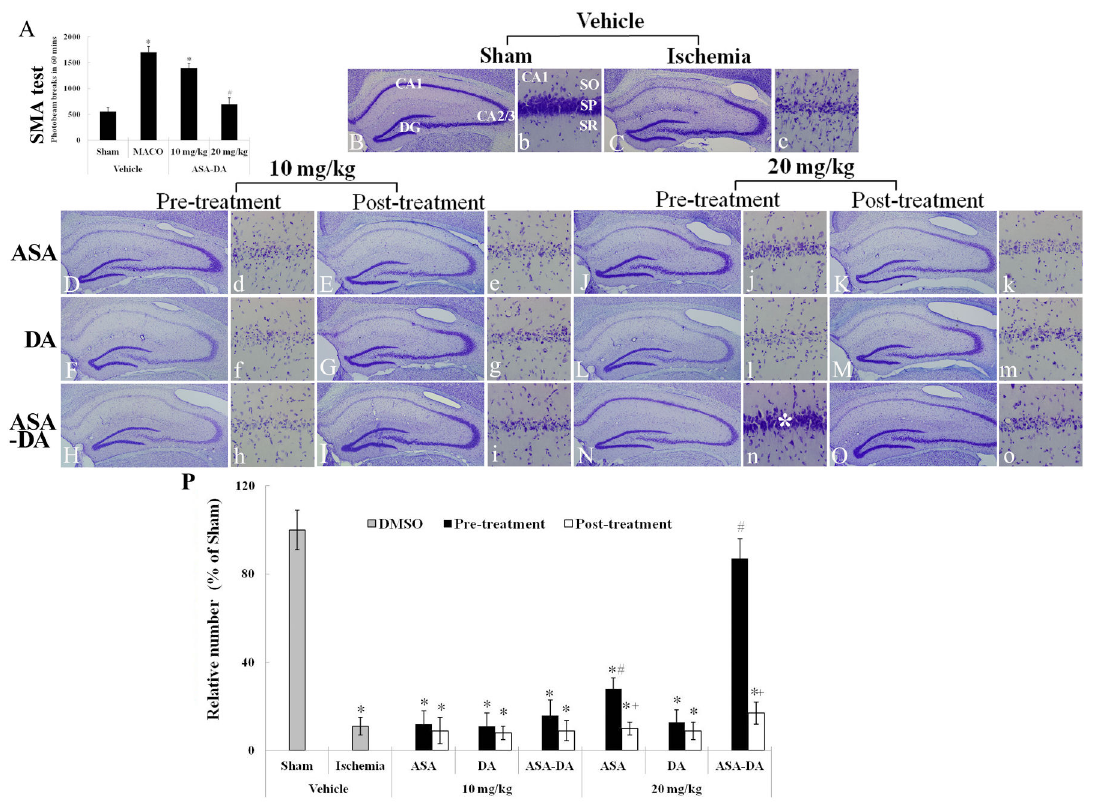
Figure 4. SMA test and CV staining. SMA (A) at 1 day after ischemia-reperfusion in ischemic gerbils and CV staining (B-O) in the gerbil hippocampus at 5 days after ischemia-reperfusion. In the vehicle-ischemia-group, SMA is significantly increased. SMA is much lower only in the 20 mg/kg ASA-DA-ischemia-group. Many CV+ cells were observed only in the 20 mg/kg ASA-DA-pre- ischemia-group (asterisk). CA; conus ammonis, DG; dentate gyrus SO, stratum oriens; SR, stratum radiatum. Scale bar = 50 and 200 µm. Relative analysis (O) as percent in the mean number of CV+ cells in the CA1 region (n = 7 per group; *P < 0.05, significantly different from the vehicle- sham-group, #P < 0.05, significantly different from the vehicle-ischemia-group; +P < 0.05, significantly different from the corresponding same treated -group). The bars indicate the means ±